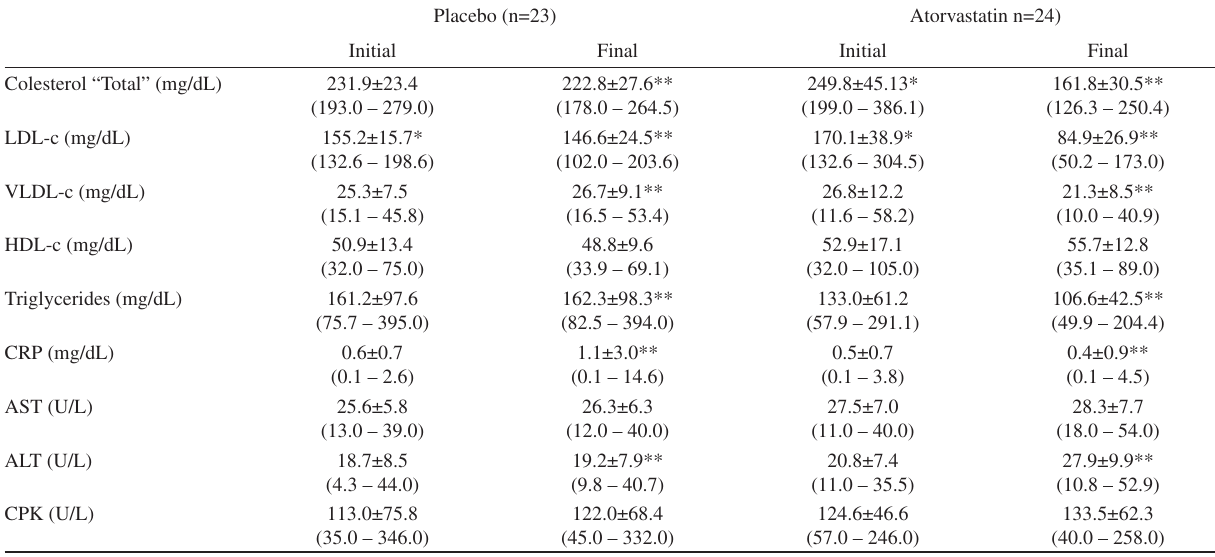
Table 2 - Laboratorial profile of subjects before and after